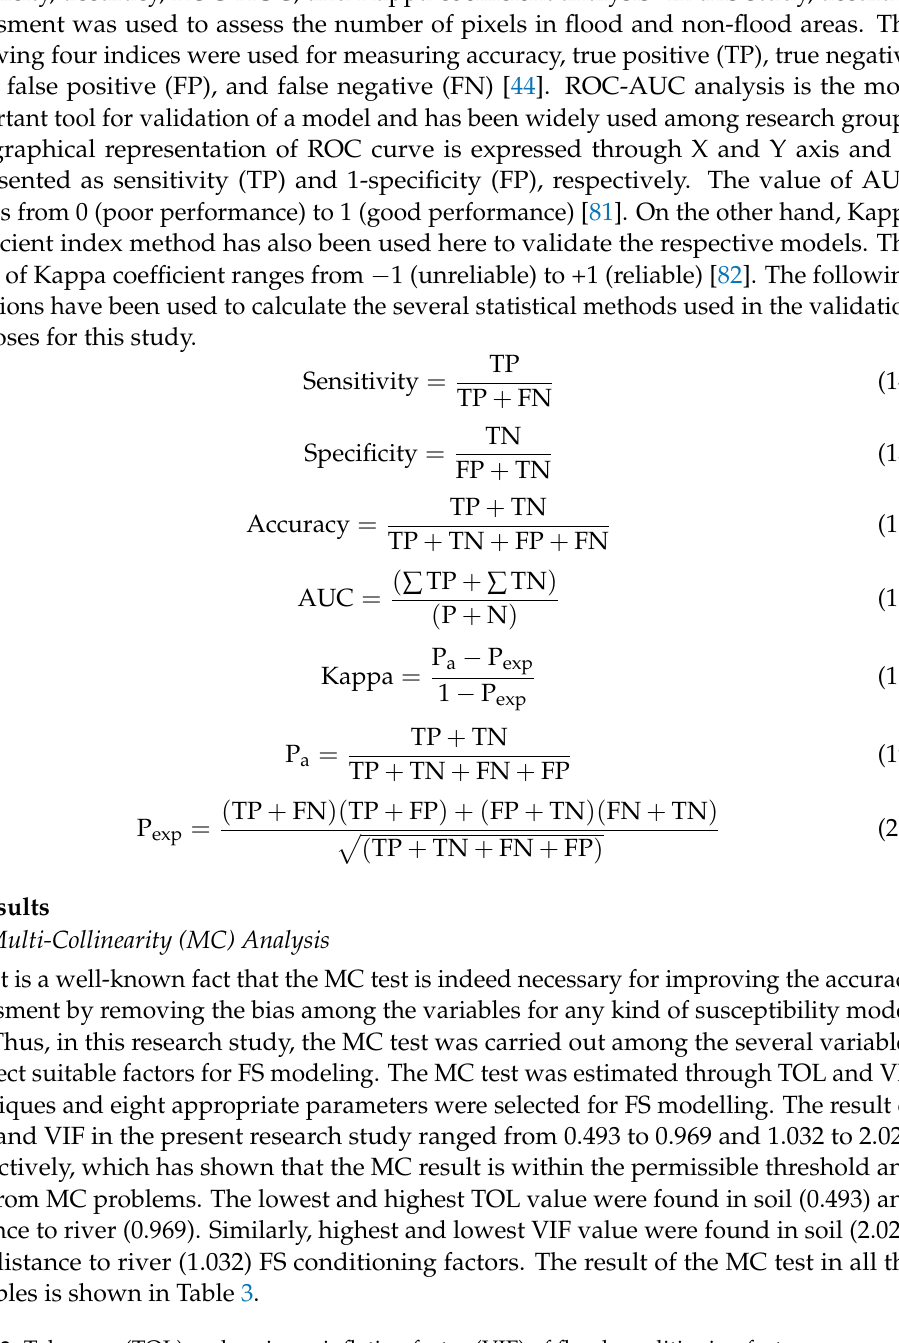
Table 3. Tolerance (TOL) and variance inflation factor (VIF) of flood conditioning